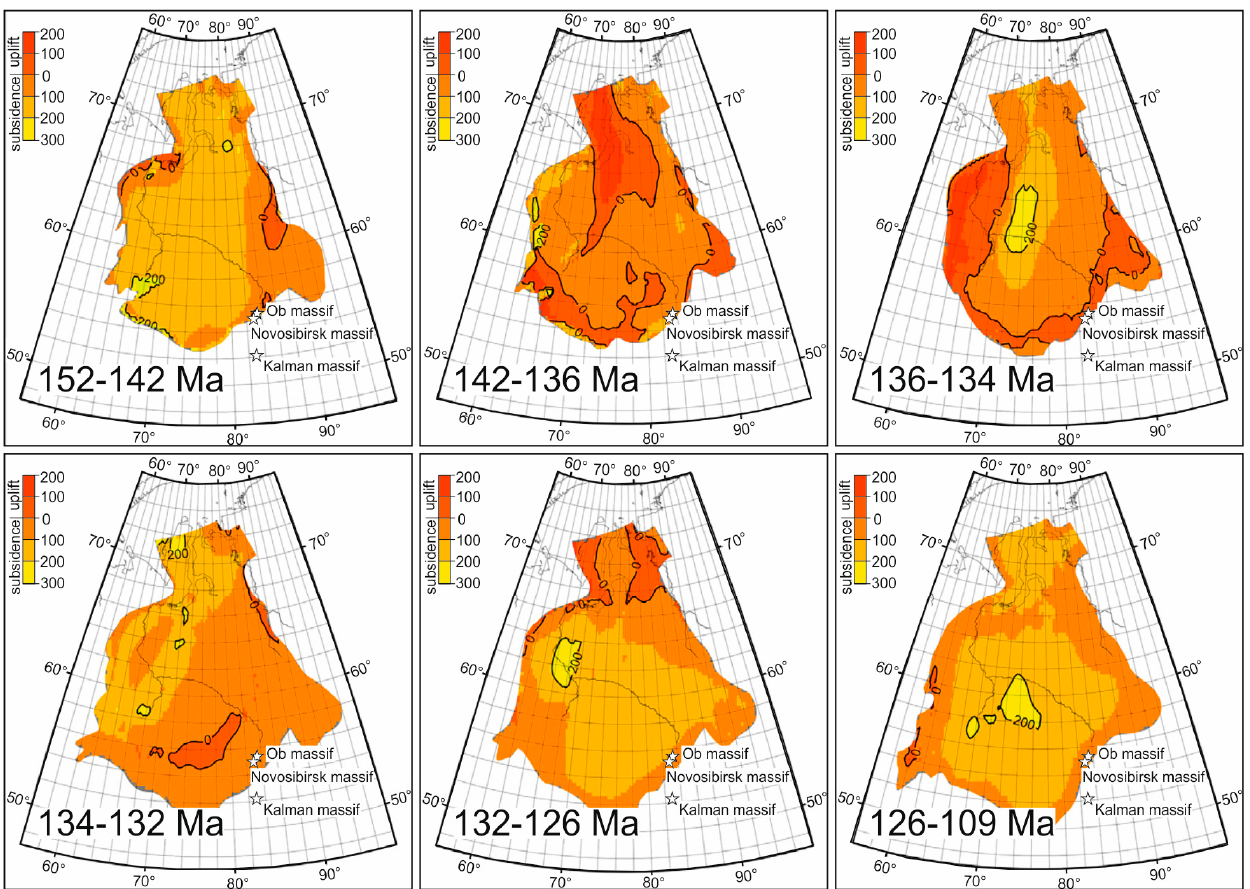
Figure 8. Estimations of tectonic uplift/subsidence (color scale in m) for the WSB during ~150 – 110 Ma based on backstripping modeling [6]. White stars show the position of the massifs studied in this article.